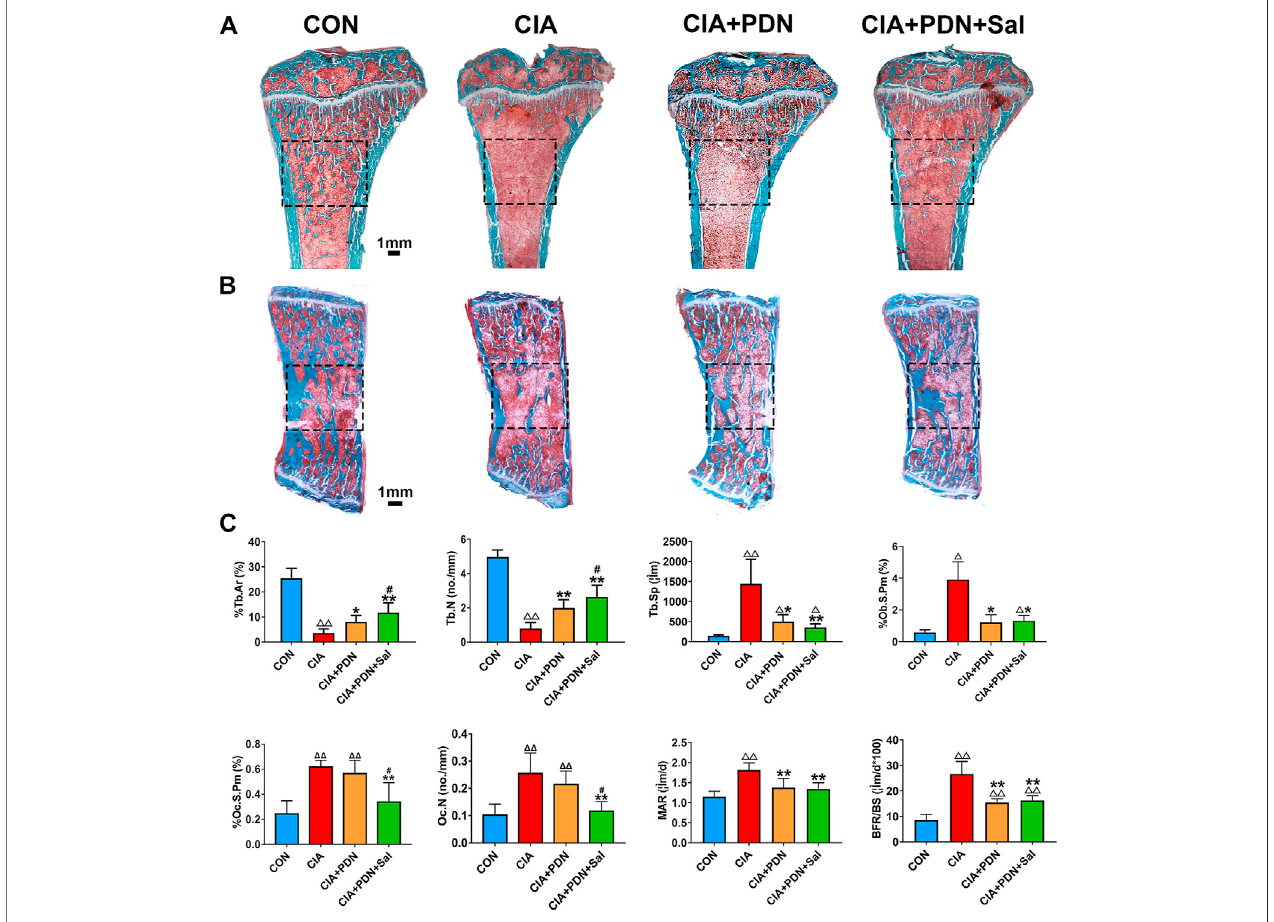
FIGURE 2 | Representative images of the tibial metaphysis (A) and the lumbar vertebra (B) and bone histomorphometric analysis of the proximal tibial metaphysis (C) Nondecalci fi edtissuesections ofthetibial metaphysis andlumbar vertebra werestainedwithMasson-Goldner trichrome. ΔΔ p < 0.01vs.CON,** p < 0.05,** p < 0.01 vs. CIA, # p < 0.05 vs. CIA+PDN ( n (cid:1)